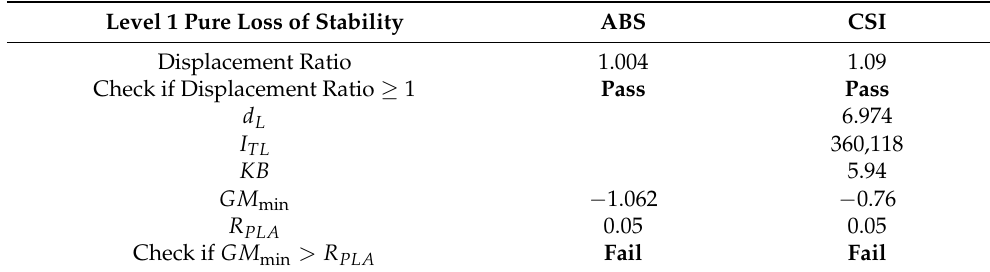
Table 30. Level 1 assessment of pure loss of stability failure mode for KCS container ship.